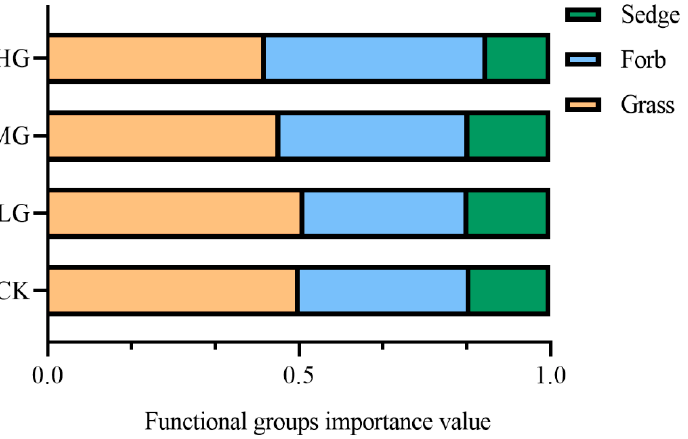
Figure 1. The importance values of functional groups under different grazing intensities. CK, no grazing; LG, light grazing; MG, moderate grazing; HG, heavy grazing.